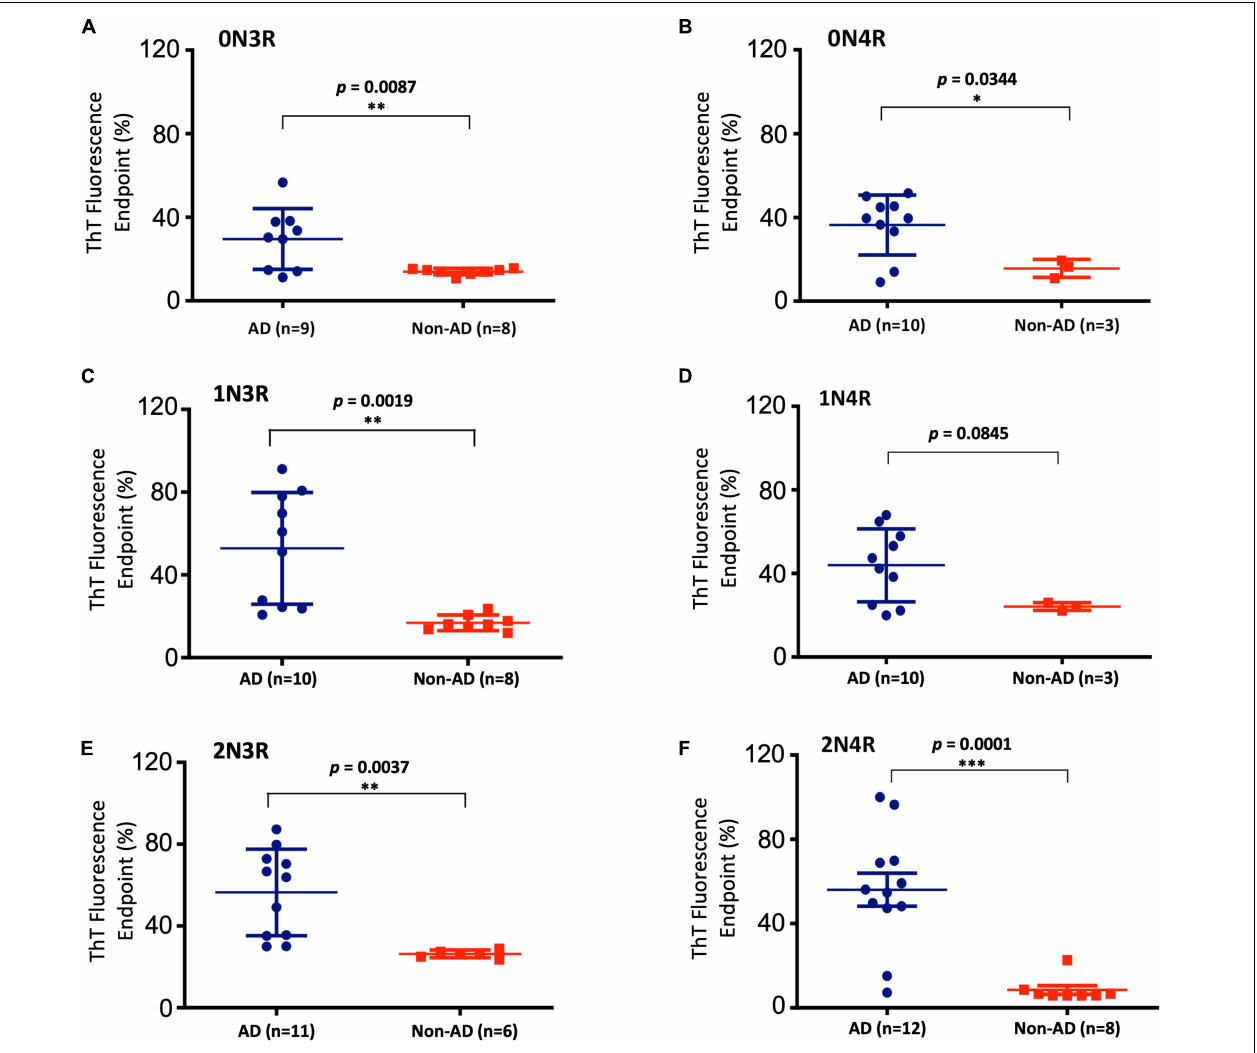
FIGURE 4 | Scattered plot and statistical evaluation of real-time quaking-induced conversion analyses (RT-QuIC) assays of six individual tau isoform (labeled) seeding activities with brain tissues of post-mortem Alzheimer’s disease (AD) and non-AD control subjects as described in Figure 3 . GraphPad Prism 6.0 software was used for statistical analyses. Subject numbers in each group are specified. False negative cases are included. ∗ p < 0.05; ∗∗ p < 0.01; ∗∗∗ p <